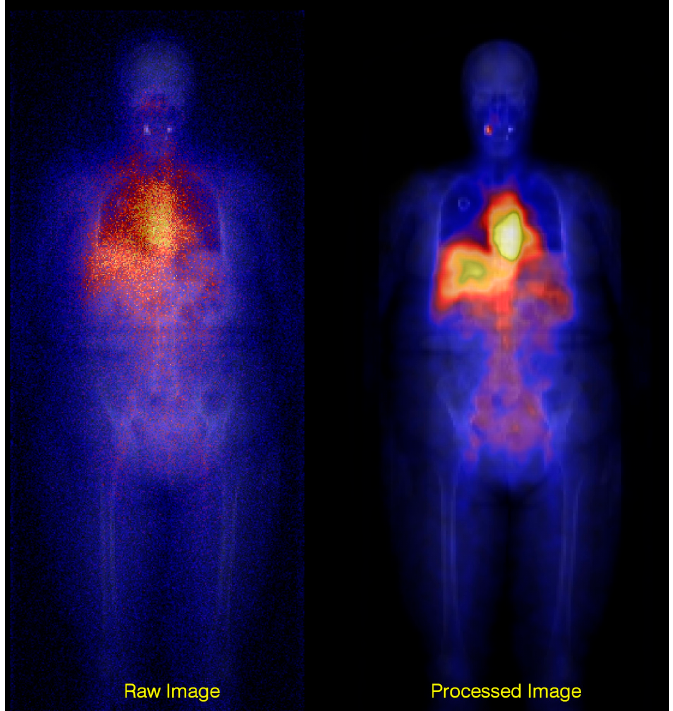
Figure 6. Overlay of a raw and processed planar scintillation-camera image on a scout image. The improvement in the appearance of the processed image, i.e., after attenuation and scatter corrections, is marked.